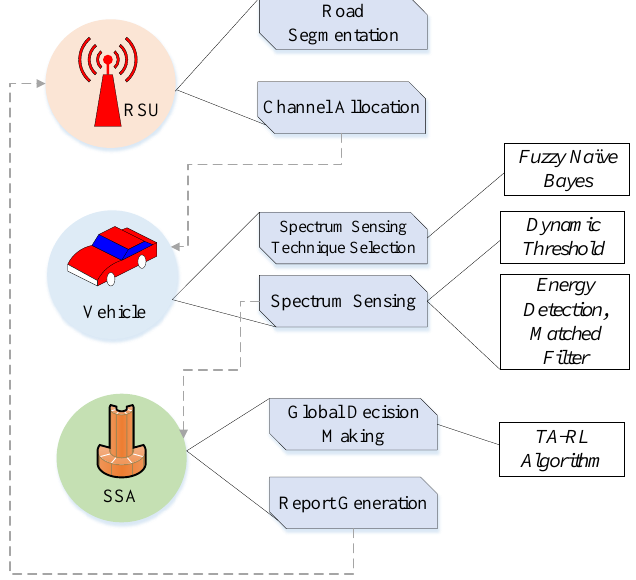
Figure 2. Entities of the proposed architecture and their responsibilities.